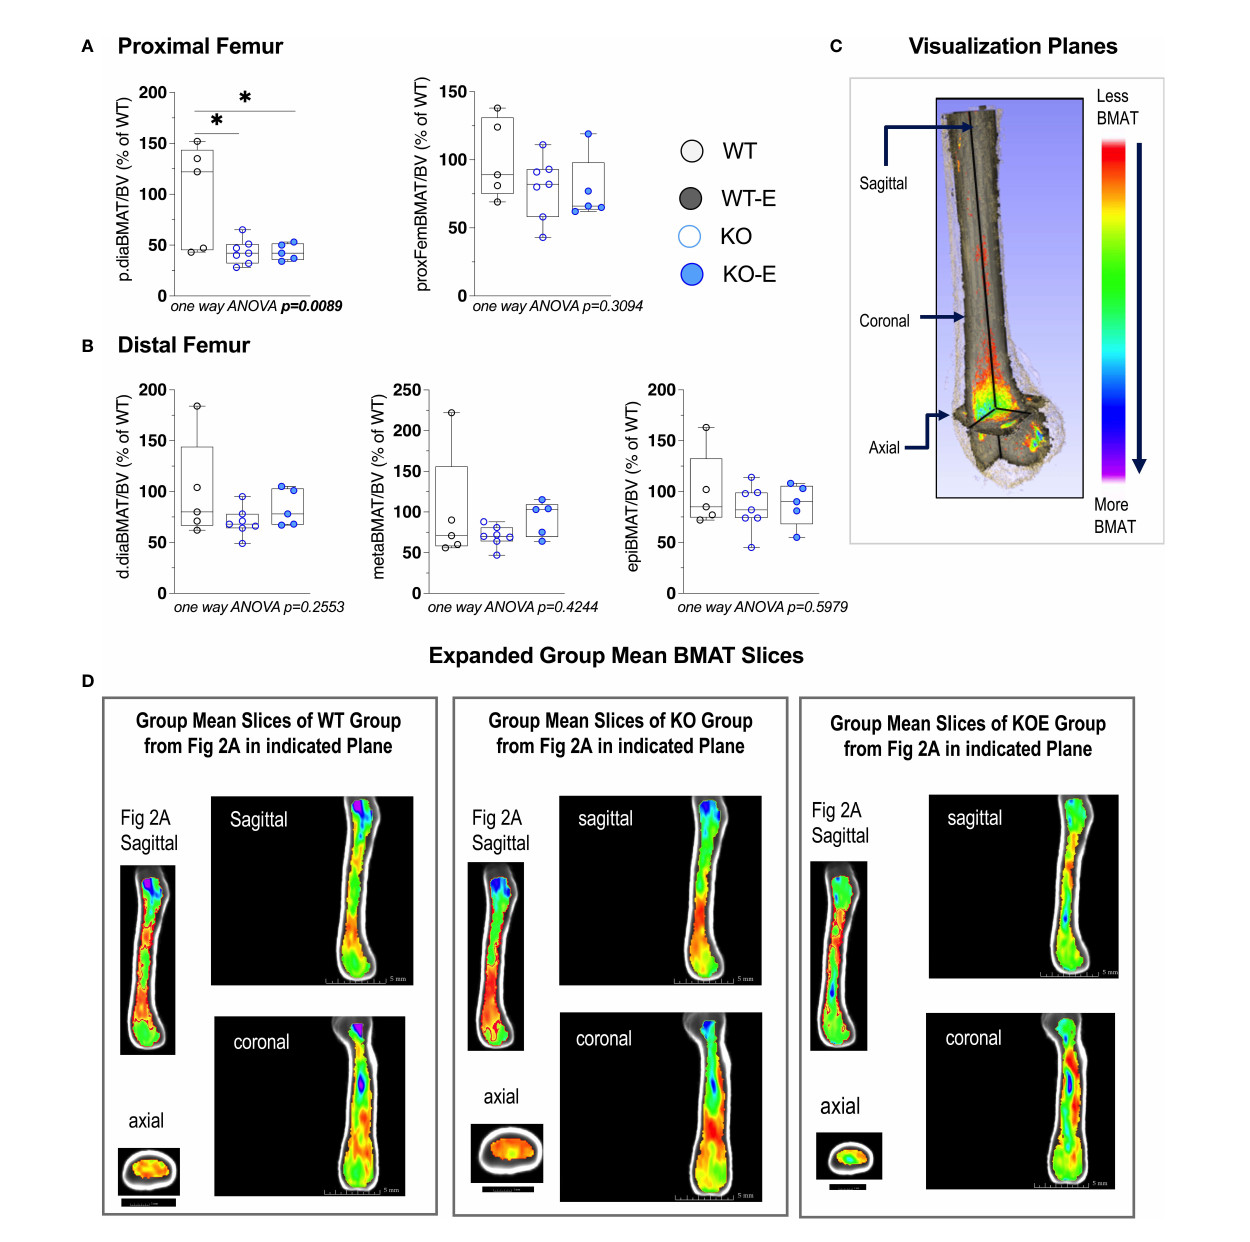
FIGURE 3 | Seipin KO exhibit reduced BMAT in the proximal femoral diaphysis. Twelve-wk.-old male SEIPIN KO allocated to exercise (E) vs non-exercise for 6 weeks, compared to wild type (WT) (n=5-8). BMAT quanti fi ed by 9.4T MRI with advanced image analysis to analyze regional distribution of BMAT relative to bone volume (BV). Data expressed as relative% BMAT to WT mean. (A) BMAT/BV assessed at the hip and the proximal diaphysis (p.dia). (B) BMAT/BV assessed at the distal diaphysis (d.dia), metaphysis (meta), and epiphysis (epi). Analyzed via one-way ANOVA with Tukey's post hoc, *p < 0.05. Data as individual values on box and whisker plots (min to max). Horizontal lines represent means. (C) Visualization planes for 9.4T MRI inboth Figures 2 and 3 . (D) Extended group mean slices obtained at indicated